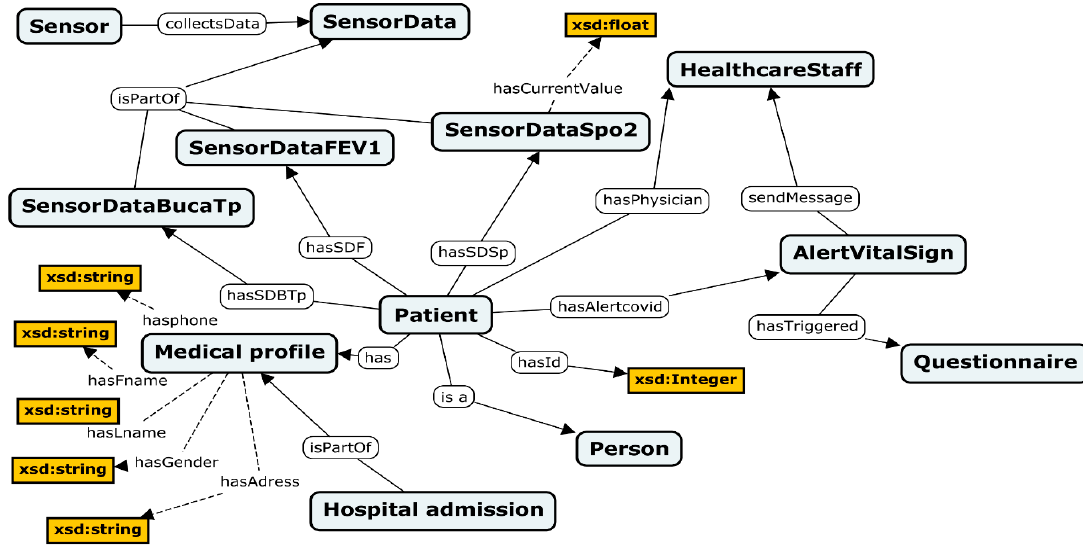
Figure 8. Evaluation vital sign ontology.